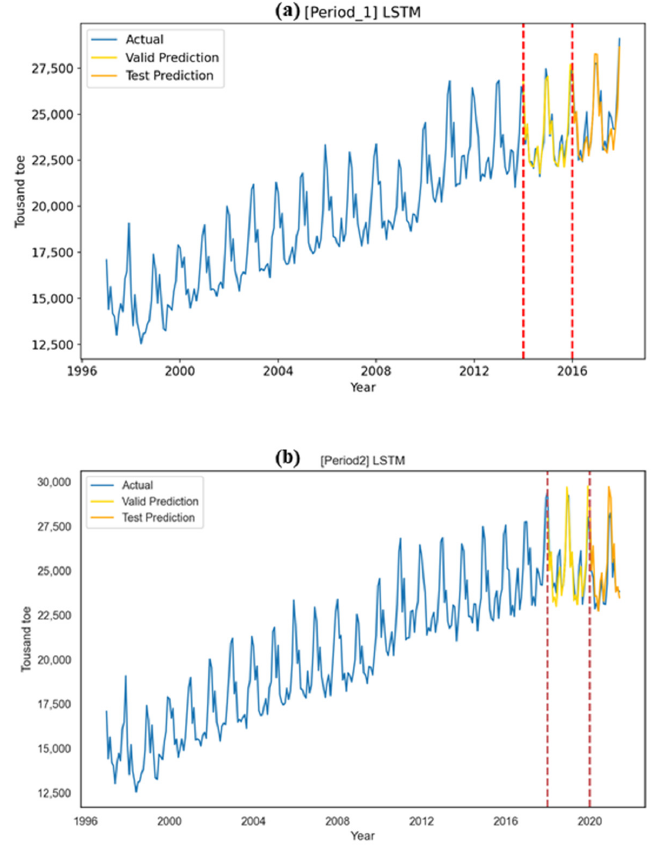
Figure 8. LSTM Forecasting.